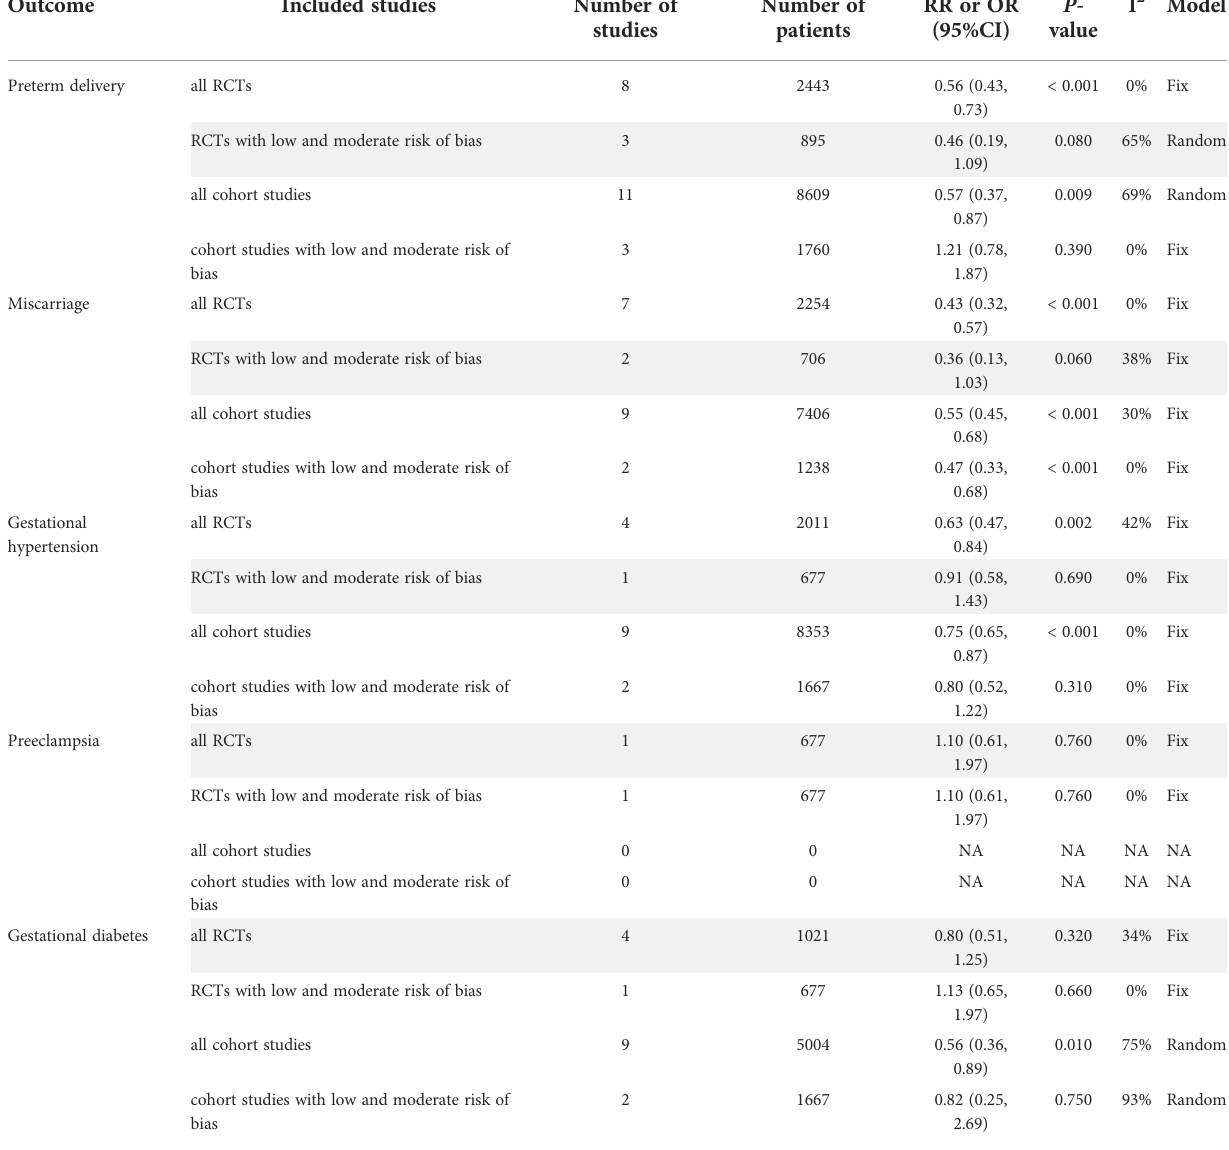
TABLE 1 Meta-analysis results for primary pregnancy outcomes. Outcome Included